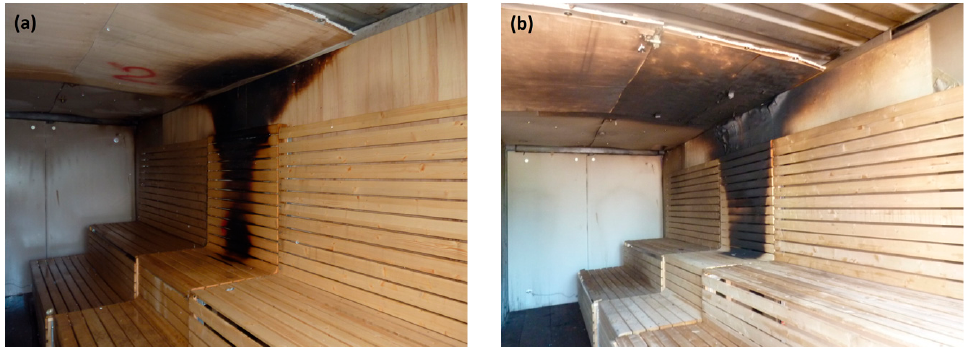
Figure 11. Bench and plywood boards at the ceiling and against the walls at the end of: ( a ) Test no. 2; ( b ) Test no. 3.